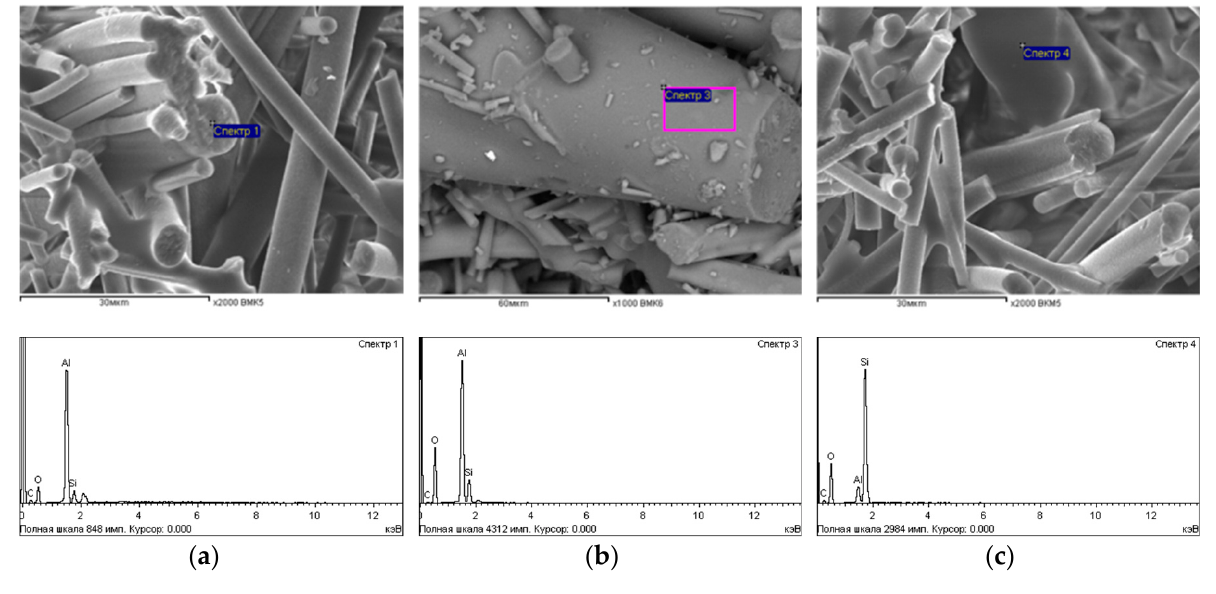
Figure 9. Micrographs indicating the areas and points of EDS as well as the corresponding spectra: ( a ) skeleton fibers, the material II; ( b ) skeleton fibers, the material I; ( c ) the area of fiber fusion (the fusion mode), the material